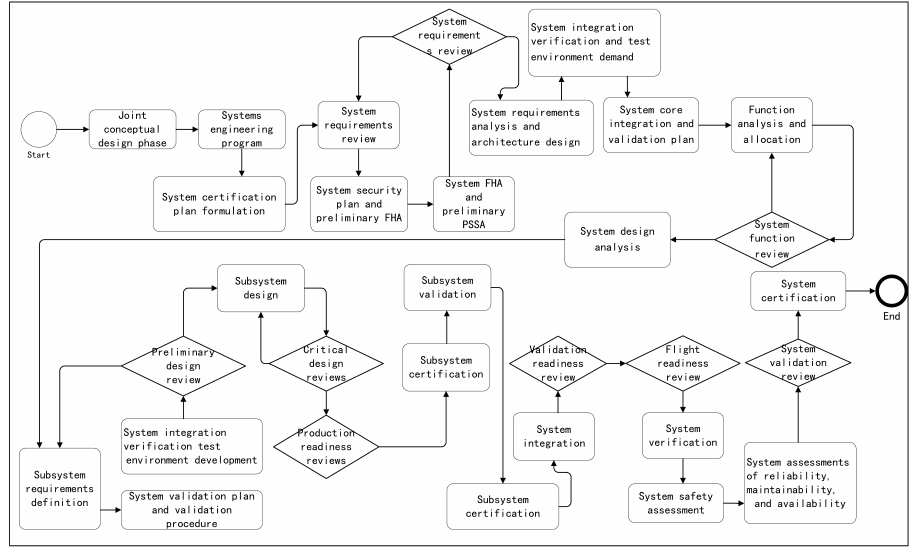
Figure 7. Aircraft avionics system process